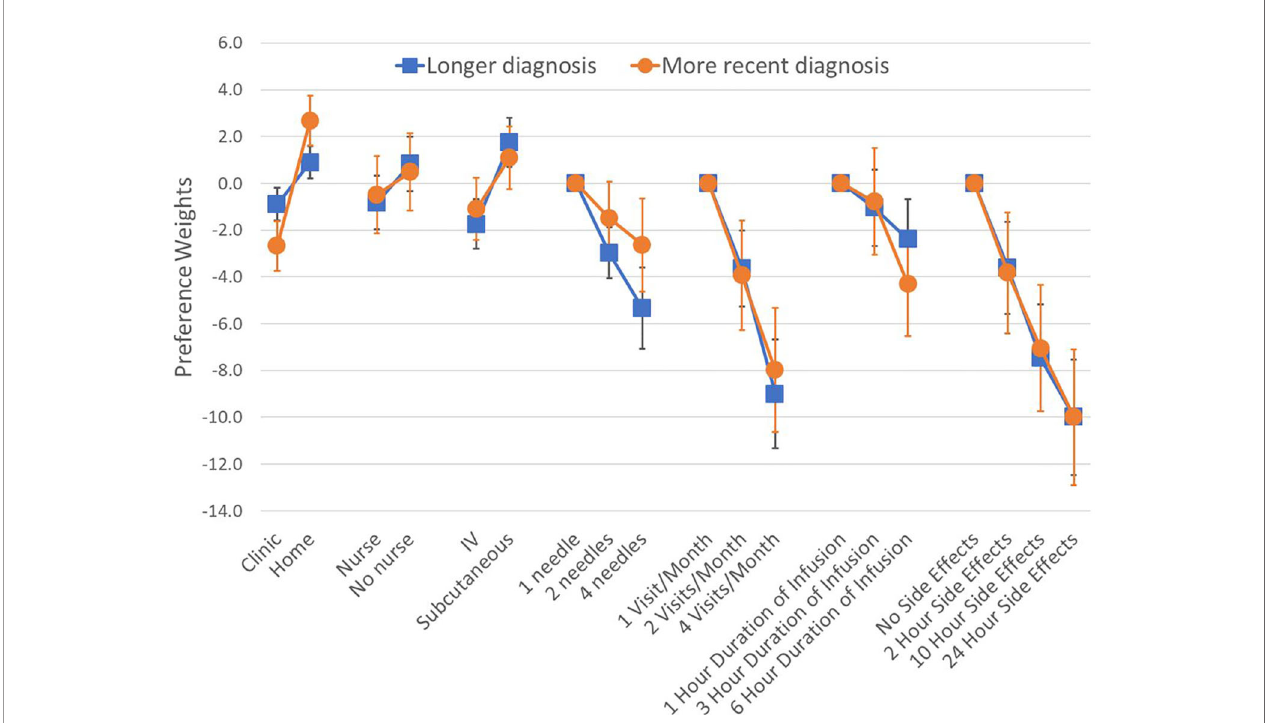
FIGURE 4 | Preference weights by time since diagnosis. Log-odds preference weights for respondents with longer (>8yrs ago) versus more recent diagnosis (<8yrs ago). Lines around each estimate indicate the 95% con fi dence interval. Results were normalized by overlapping the preference weights for duration of side effects to allow direct comparison between plots. Statistically-signi fi cant differences between the groups were found for the administration